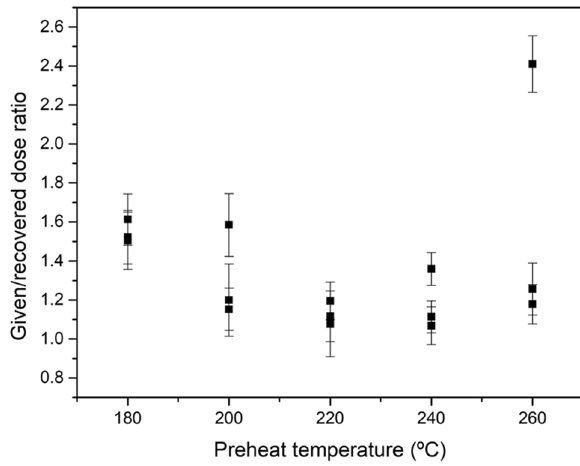
Figure 3. Preheat dose recovery test results for sample M1.